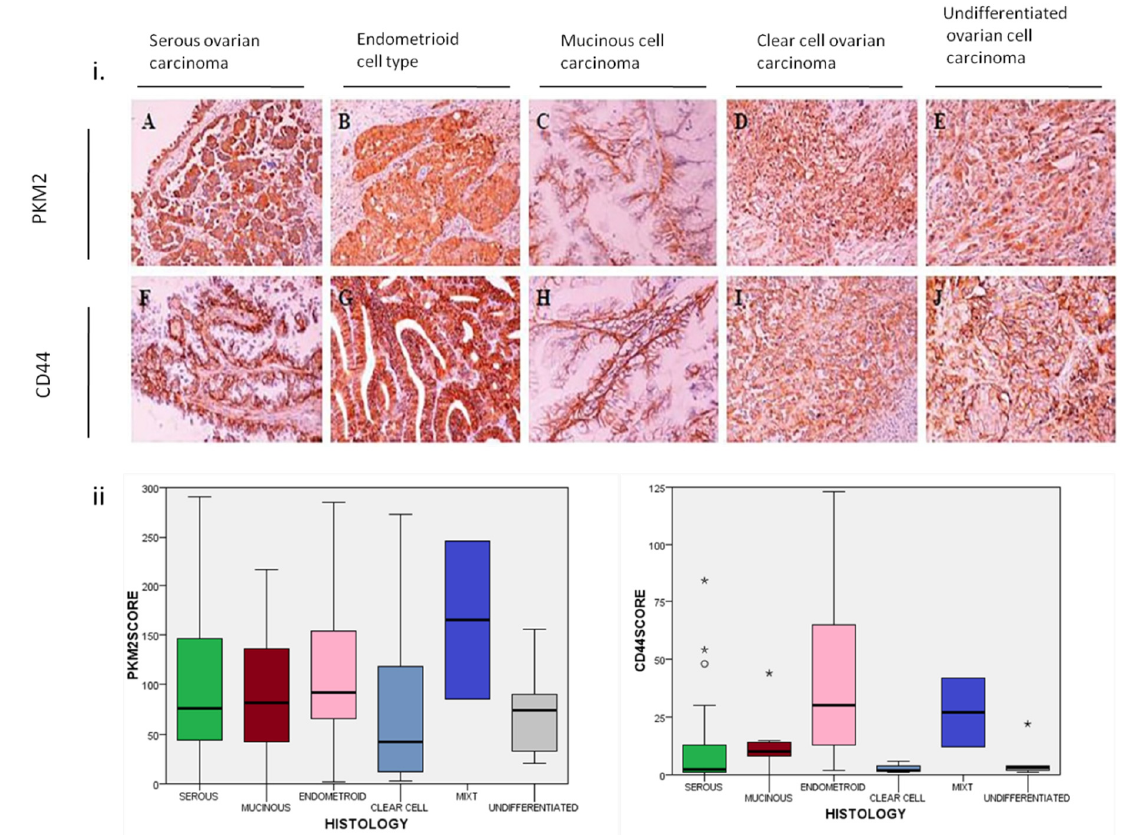
Figure 1. ( i ) Immunohistochemical (IHC) representative staining of PKM2 in the cytoplasm and of CD44 mainly in cell membranous and in cytoplasm in different histological subtypes of EOC tumor tissues (magnification 200×). ( A ) PKM2 and ( F ) CD44 staining in serous ovarian carcinoma. ( B ) PKM2 and ( G ) CD44 staining in endometroid cell type. ( C ) PKM2 and ( H ) CD44 protein expression in mucinous cell carcinoma. ( D ) PKM2 and ( I ) CD44 in clear cell ovarian carcinoma. ( E ) PKM2 and ( J )